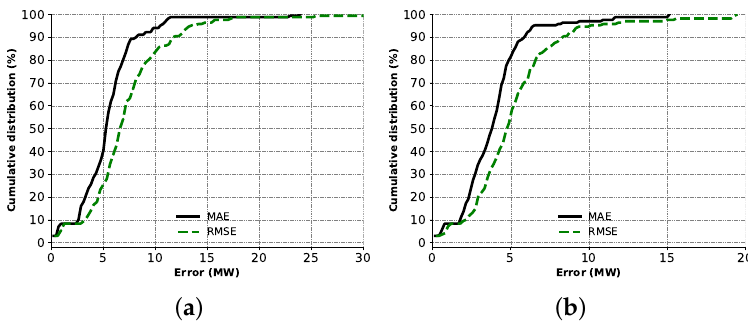
Figure 6. Error distribution of the forecast results. The data are from the ( a ) RECO and ( b )